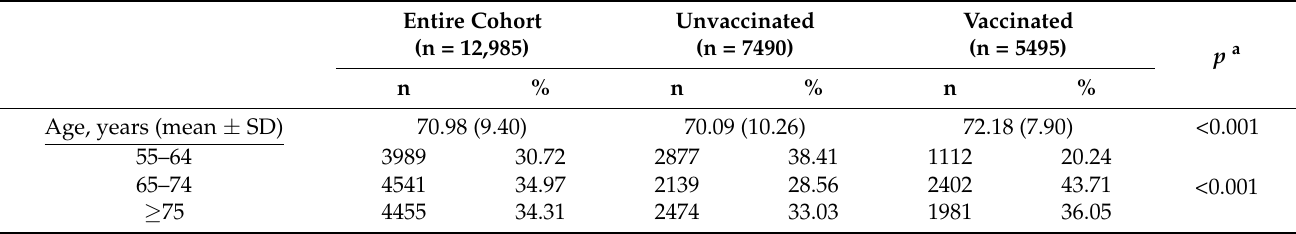
Table 1. Characteristics of sample